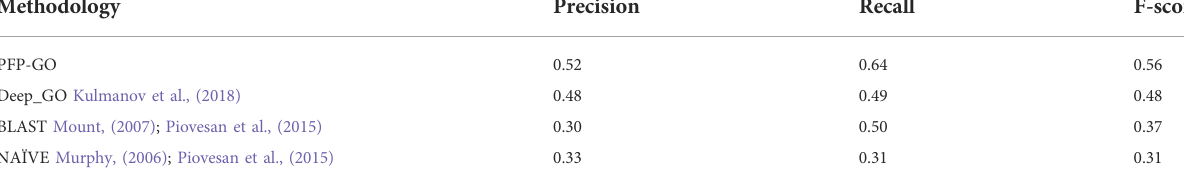
TABLE 4 Performance analysis of PFP-GO with other methods based on PPI network and sequence.